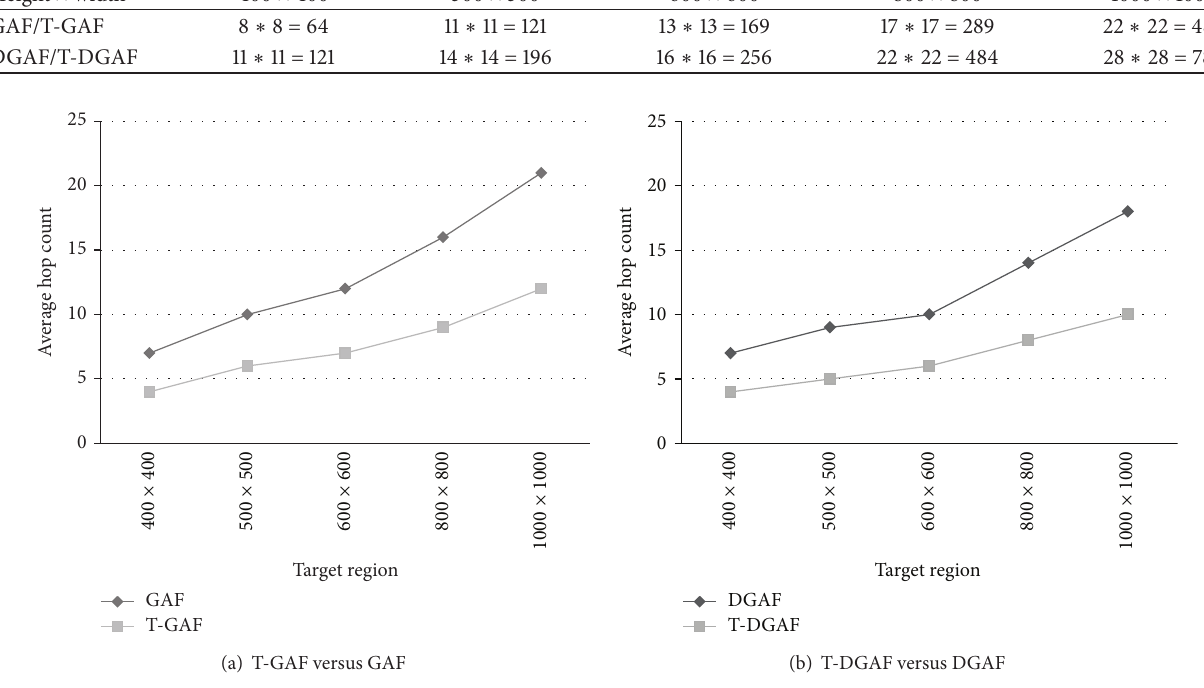
Figure 7: Comparison of the average hop count for different size of the target regions.